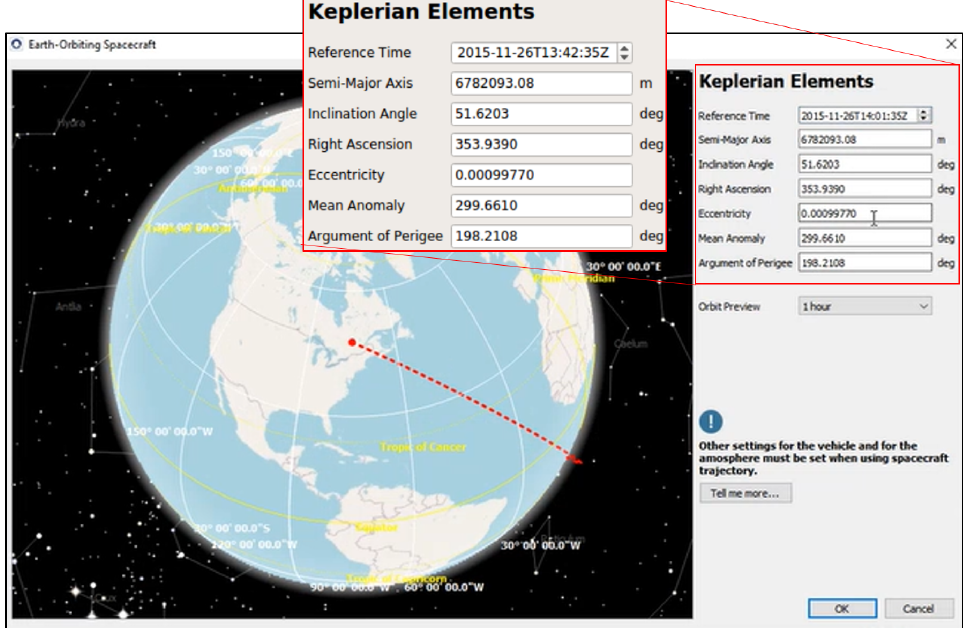
Figure 6. Screenshot of LEO satellite orbital parameters